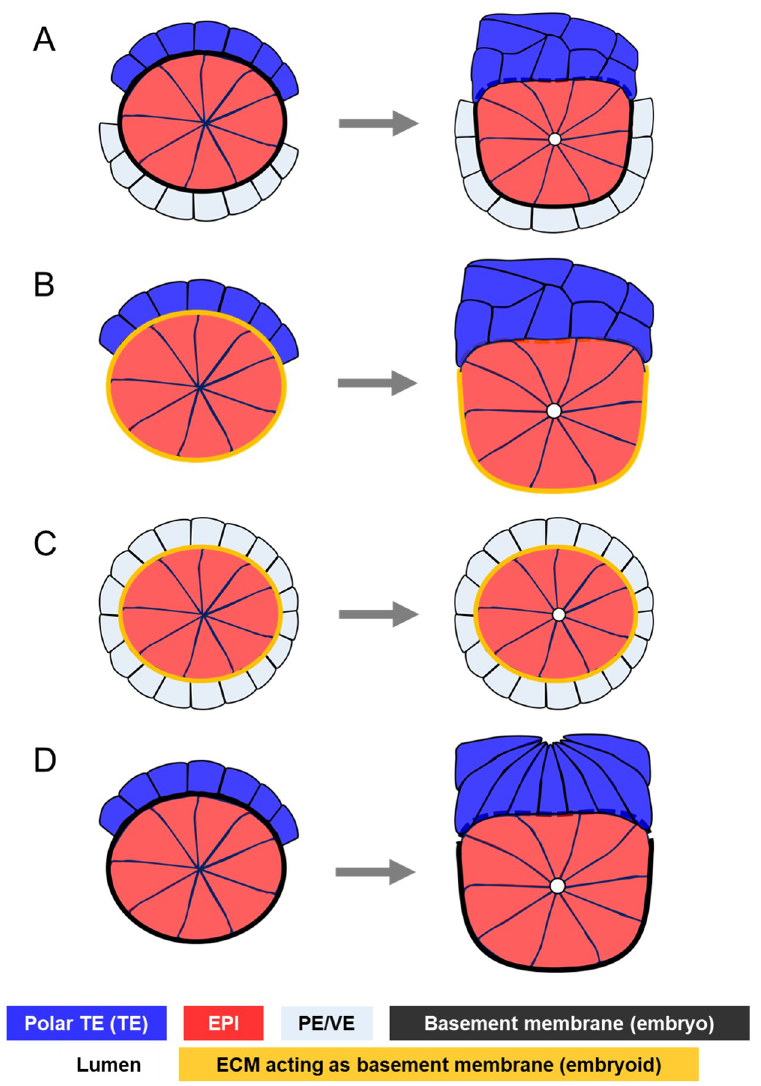
Fig 1. Review of epiblast symmetry breaking theories. A . The basement membrane separating the epiblast and the primitive endoderm moulds the epiblast into a cup while it disintegrates between the epiblast and the trophectoderm in mouse embryos [4]. B . Embryoid structures featuring epiblast and trophectoderm stem cells surrounded by an ECM acting as a basement membrane (ETS-embryoids) replicate mouse embryogenesis by forming body structures similar to those observed in normal embryonic development [13]. Here the presence of the trophecdoderm shows that this tissue might be required for symmetry breaking in the epiblast and cup shape acquisition. C . Embryoid structures featuring epiblast and primitive endoderm stem cells surrounded by an ECM acting as a basement membrane (EXE- embryoids) do not break symmetry in the epiblast, but initiate lumenogenesis [14]. This evidences the requirement of the trophectoderm for the remodelling of the epiblast. D . Trophectoderm morphogenesis during mouse implantation. Trophectodermal cells elongate, then undergo apical constriction, resulting in the tissue folding [10]. This suggests that epiblast remodelling into a cup might be a mechanical response to trophectoderm dynamics.